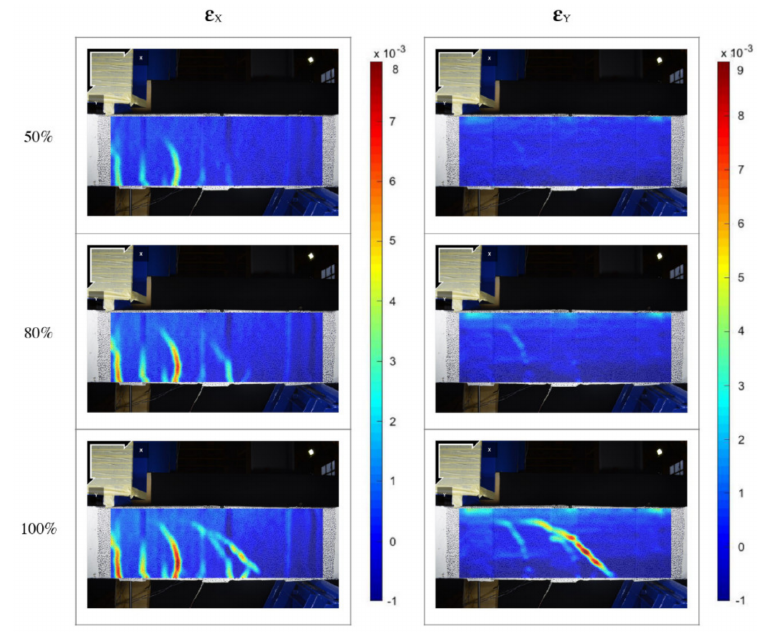
Figure 8. B-D-1L-3S: Strain evolution obtained by using DIC technique. The strain colour maps of the U-Wrapped beam with two layers ( B-D-2L-3S ) is rep- resented in Figure 9. In this case, both the horizontal and the vertical strains start at the interface reinforcement concrete beam support region, whereas the area strengthened with SRG strips showed the lower value of strains, demonstrating the ability of the adopted reinforcement to increase the stiffness as well as the strength of the beam. As the beam previously described, the reinforced regions were affected by lower deformations than the un-reinforced strips and the SRG system-concrete interfaces.